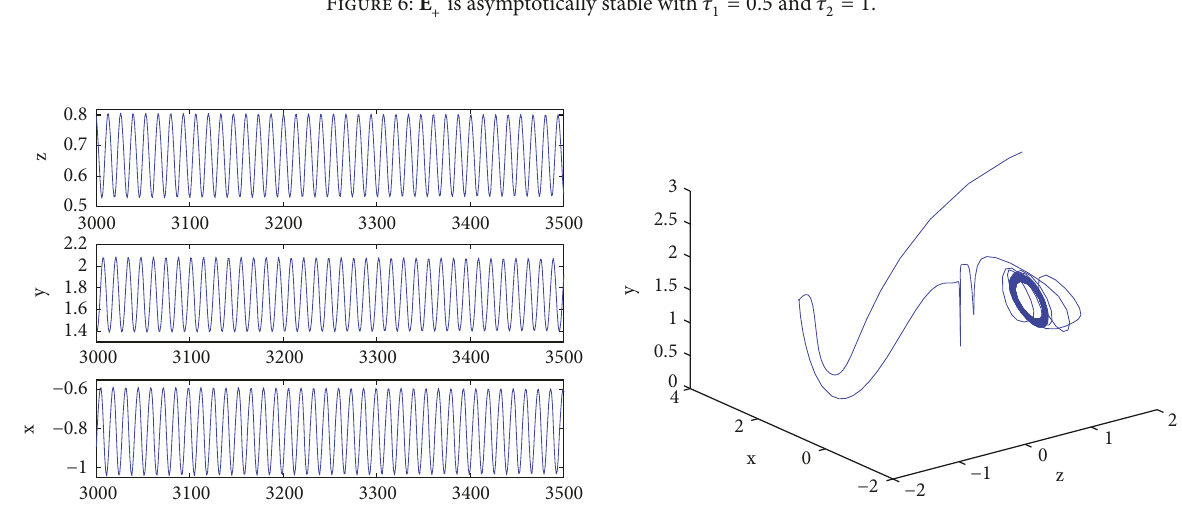
Figure 6: E ∗ + is asymptotically stable with 𝜏 1 = 0.5 and 𝜏 2 = 1 .